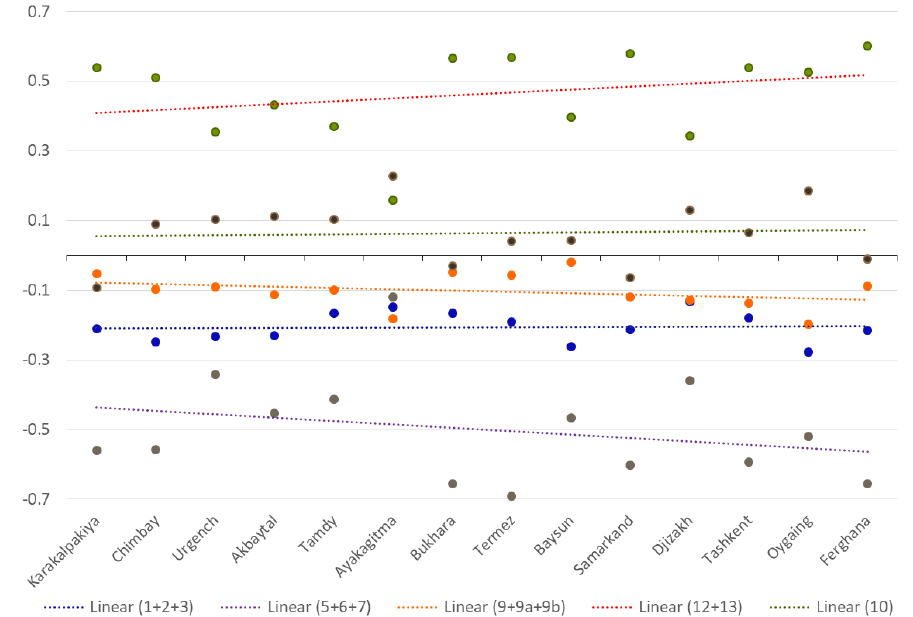
Figure 9. Pearson correlation of the main SWT and the mean air temperature for 1961–2016.